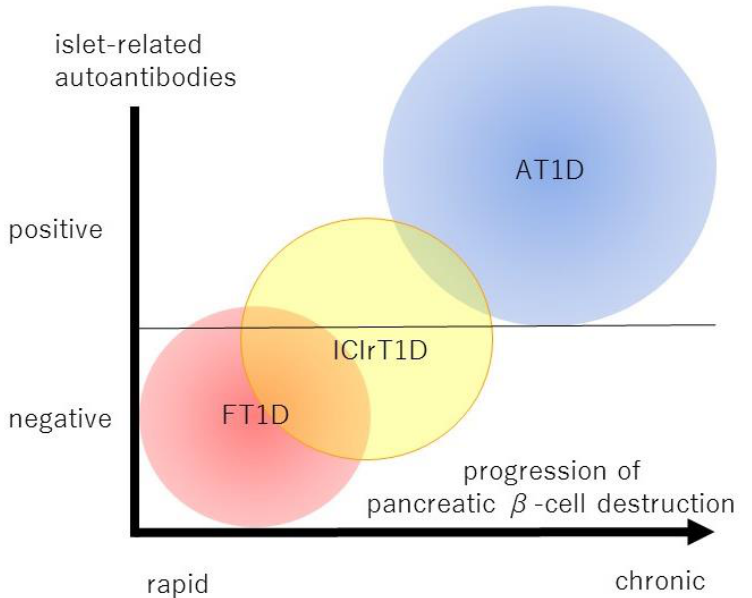
Figure 1. This schema shows the positioning of fulminant type 1 diabetes (FT1D), ICI-related type 1 diabetes (ICIrT1D) and autoimmune type 1 diabetes (AT1D) based on the presence of islet-related autoantibodies and the rapidity of pancreatic β -cell destruction. ICIrT1D exhibits various phenotypes ranging from FT1D-like to AT1D-like, but the average phenotype is intermediate between FT1D and AT1D, and is considered an independent entity from the etiological approach.